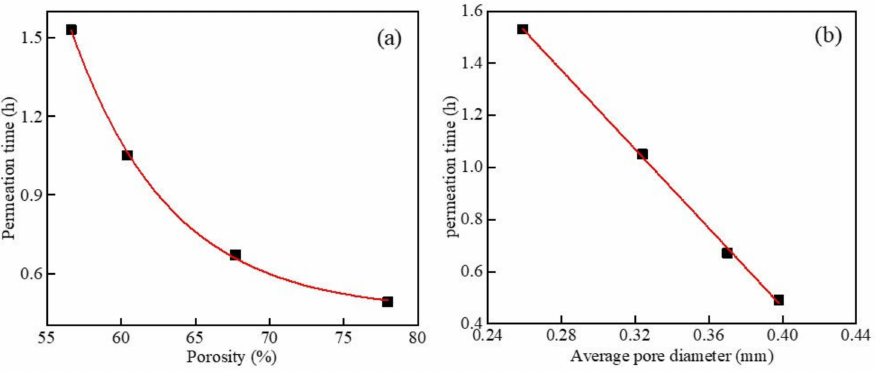
Figure 17. Water absorption versus porosity ( a ) and average pore diameter ( b ) of the recycled foamed concrete containing MSWI powder with different water–binder ratios.